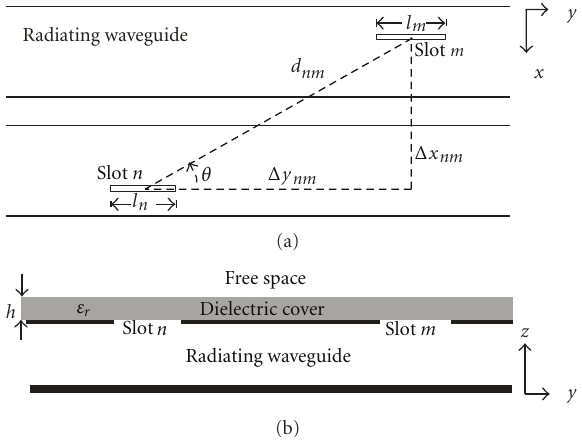
Figure 1: Two arbitrary slots in a planar array (a) top view and (b) sectional